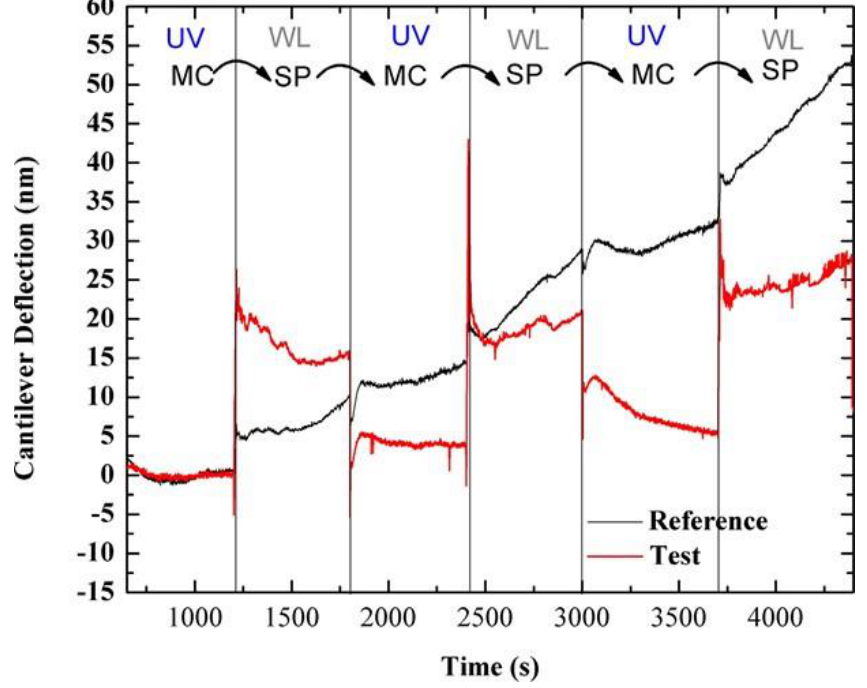
Figure 4. Typical average deflection response of the test (red) and reference (black) microcantilevers during 5 cycles of alternating UV and white light illumination.